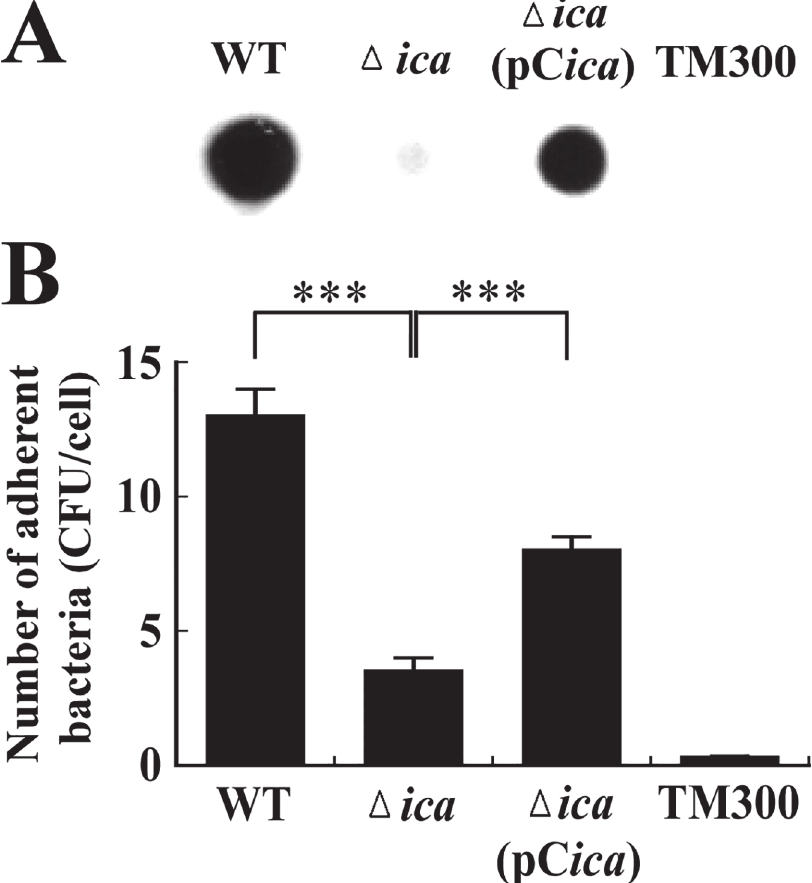
Fig 1. PIA/PNAG production and adherence of S . aureus to nasal epithelial cells. (A) PIA/PNAG was extracted from S . aureus strains and detected using WGA-biotin. Following incubation with HRP-streptavidin, PIA/PNAG was visualized by chemiluminescence detection. (B) The adherence of bacteria to RPMI 2650 cells was determined using an adherence assay. The number of bacteria that adhered to the cells was determined by CFU enumeration, and the average number of bacteria adhered to each RPMI 2650 cell was calculated. S . carnosus TM300 was used as a control. Significant differences are denoted with *** p - value <